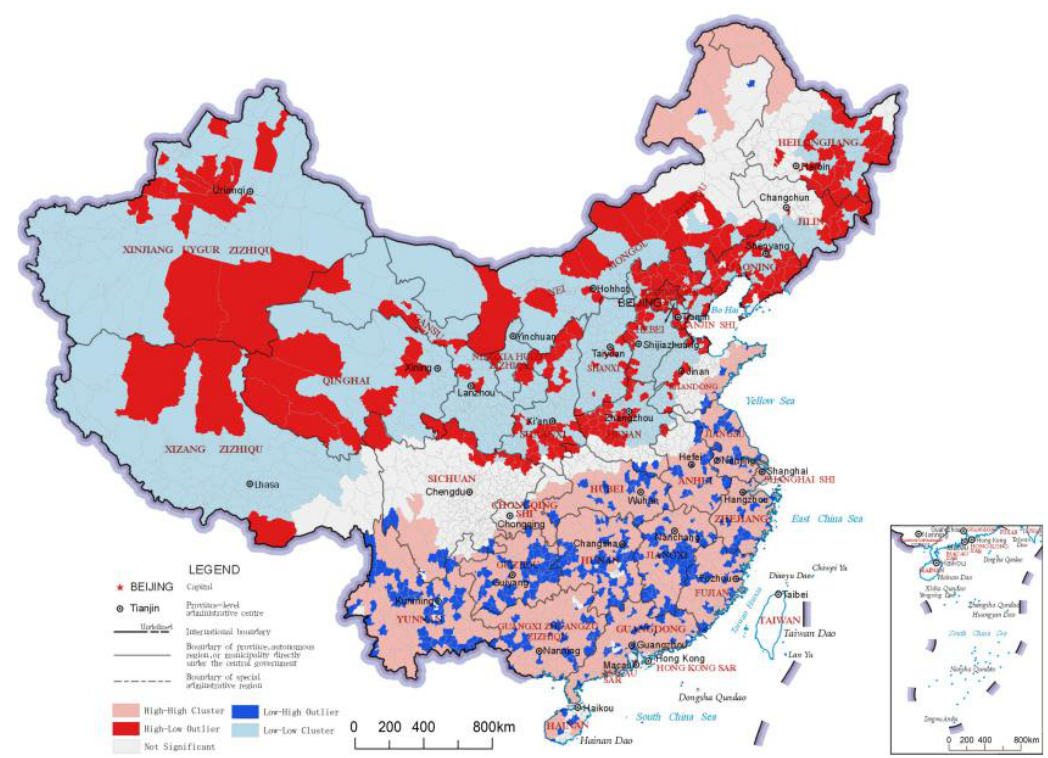
Figure 10. LISA cluster map of composite GEP indices of the county-level regions in China.